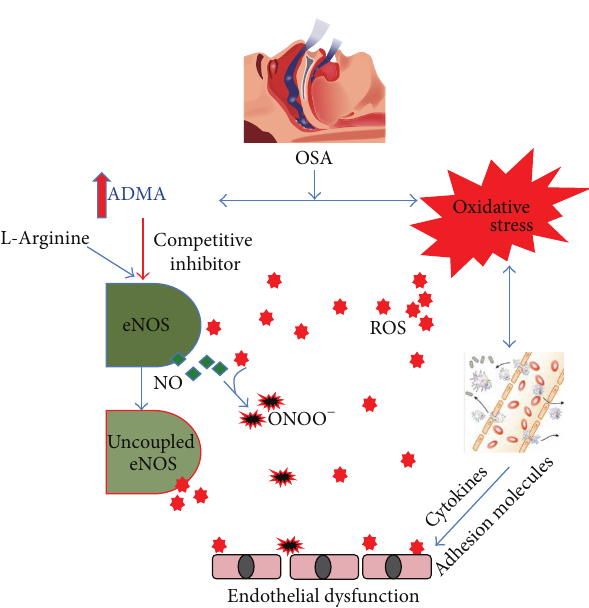
Figure 2: Oxidative stress and high ADMA levels can cause endothelial dysfunction in OSA. ADMA: asymmetric dimethylargi- nine; eNOS: endothelial nitric oxide synthase; NO: nitric oxide; ONOO − : peroxynitrite; OSA: obstructive sleep apnea; ROS: reactive oxygen